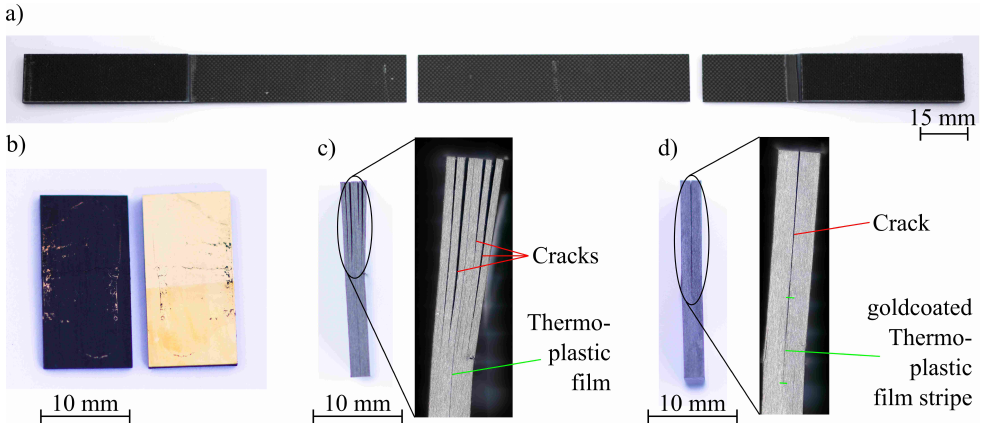
Figure 14. Typical fracture behavior of ILS and tensile specimens: ( a ) tensile specimen fragmented into several small pieces, ( b ) ILS specimen broken in the middle plane between gold and epoxy resin, ( c ) cracks in an ILS specimen with integrated PEI film and ( d ) crack propagated from a gold coated PES film stripe embedded in the center of an ILS